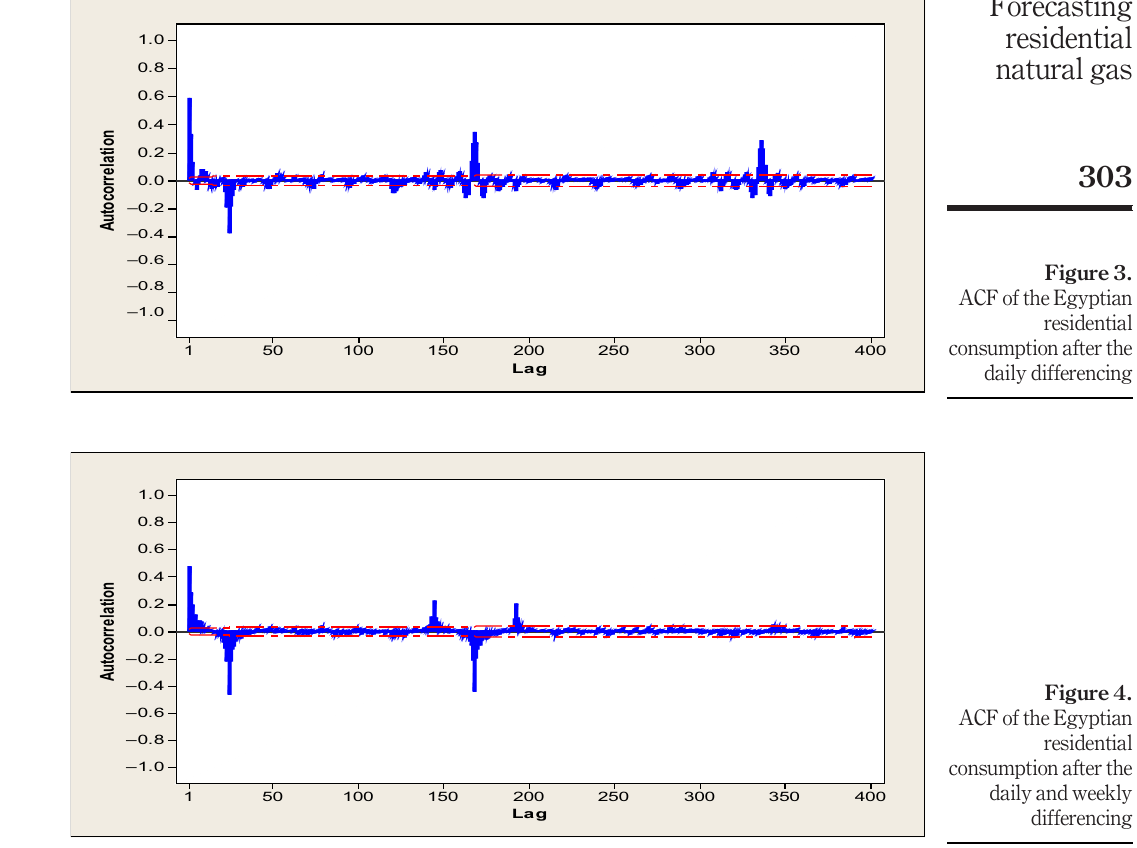
Figure 4. residential differencing